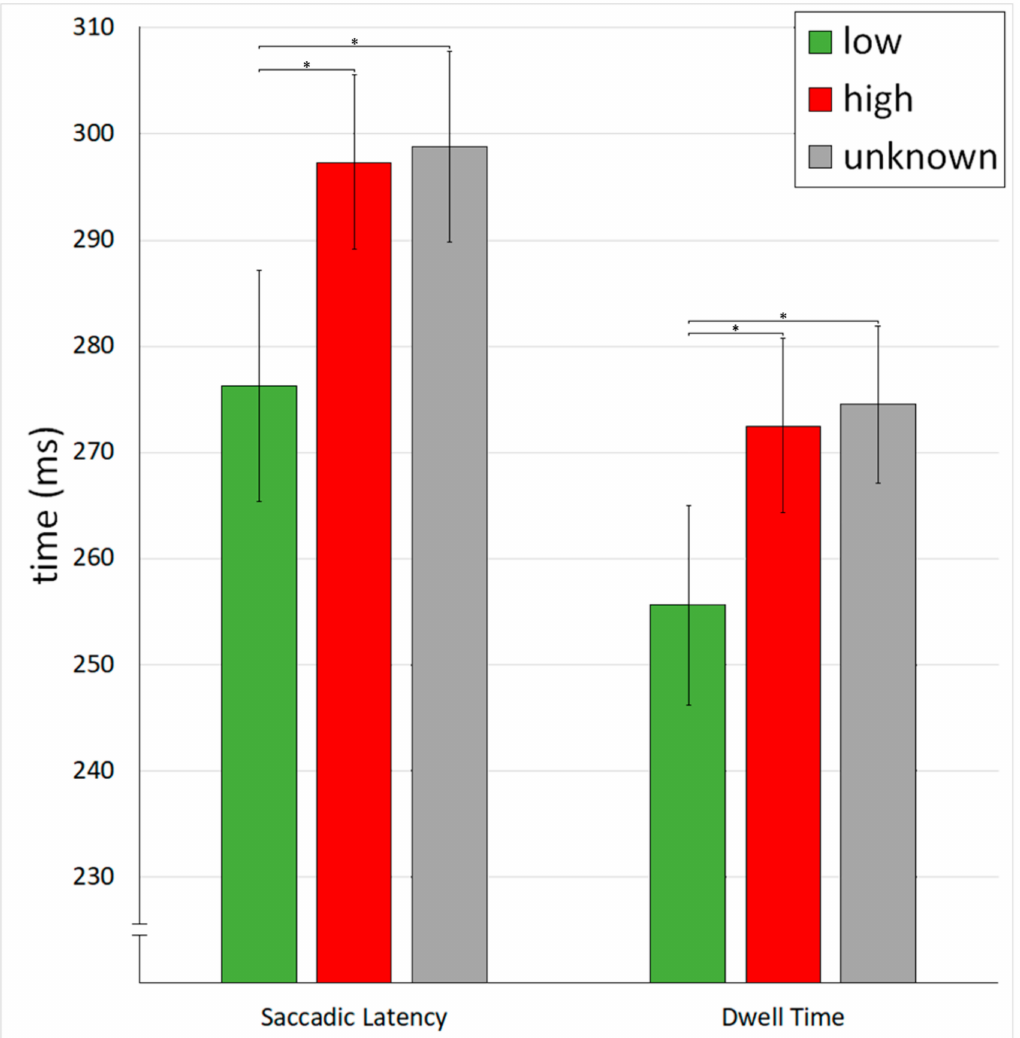
Figure 2. Mean saccadic latency and dwell time for trials in which food appeared in the current gaze location for three CNI conditions: Low (green CNI / low sugar), high (red CNI / high sugar), and unknown (gray CNI / unknown sugar). Whiskers indicate standard errors. Asterisks indicate Holm-adjusted p <